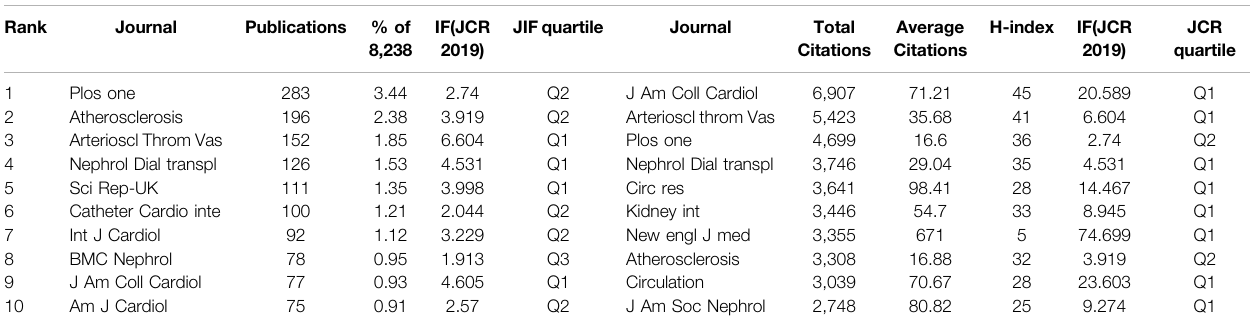
TABLE 4 | Top 10 journals distributed by publications and